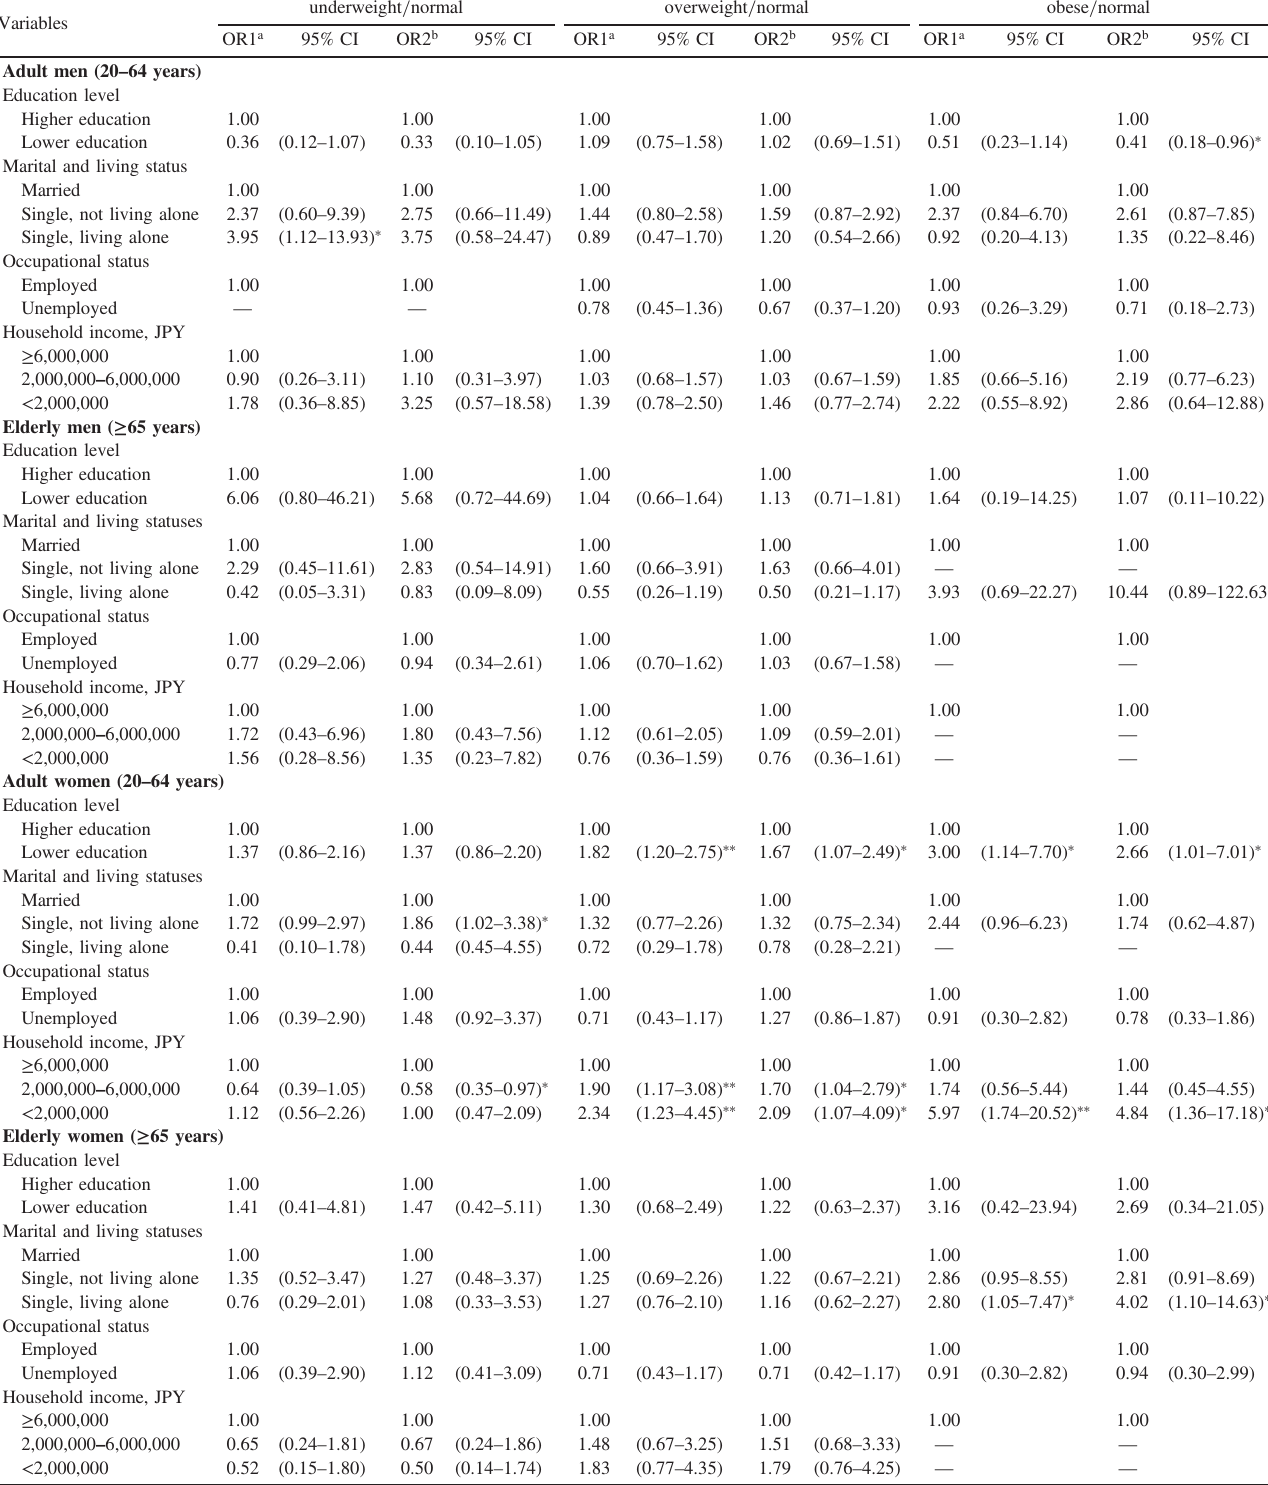
Table 3. Socioeconomic status and odds ratios for being underweight, overweight or obese, NIPPON DATA2010 (multinomial logistic regression, n =